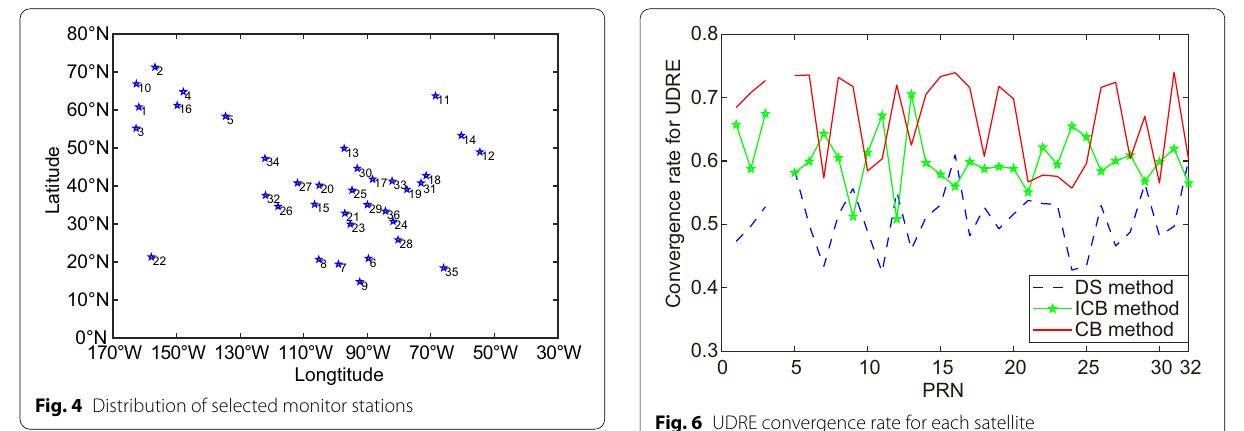
Fig. 6 UDRE convergence rate for each satellite